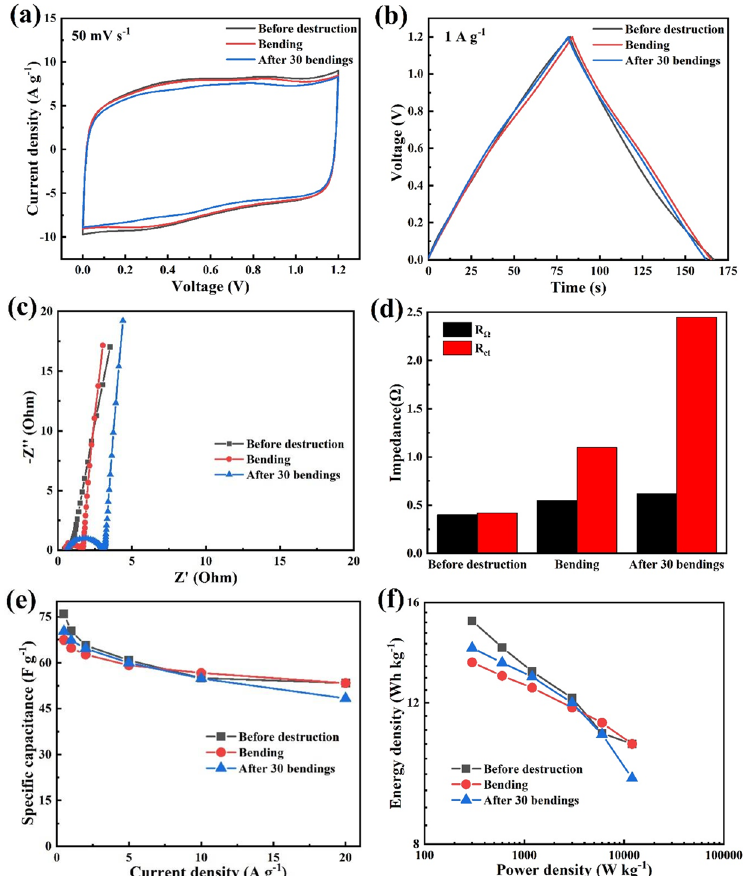
Figure 8. Performance comparisons of hydrogel supercapacitors in different states of ( a ) CV curve, ( b ) GCD curve, ( c ) EIS curve, ( d ) ohmic impedance and electrochemical impedance, ( e ) specific capacitance-current density curve, and ( f ) energy density-power density curve.